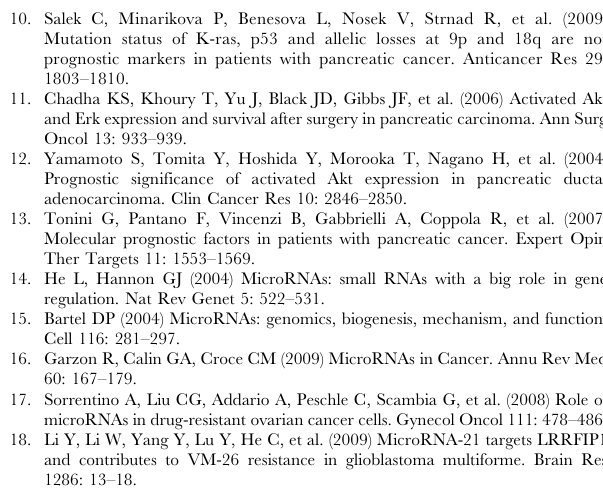
Figure S4 Pooled analysis Korean and Italian cohorts: disease- Figure S5 Pooled analysis Korean and Italian cohorts: overall survival curves according to miR-21 expression and treatment status. Table S1 Clinicopathological and biological factors analyzed.